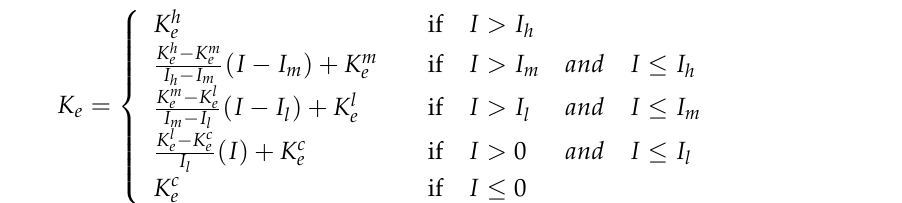
Figure 7. Graphical representation of the parameter K e . I c 1 and I c 2 are charge currents (negative values) and I l , I m and I h (positive values) are discharge currents used in the identification